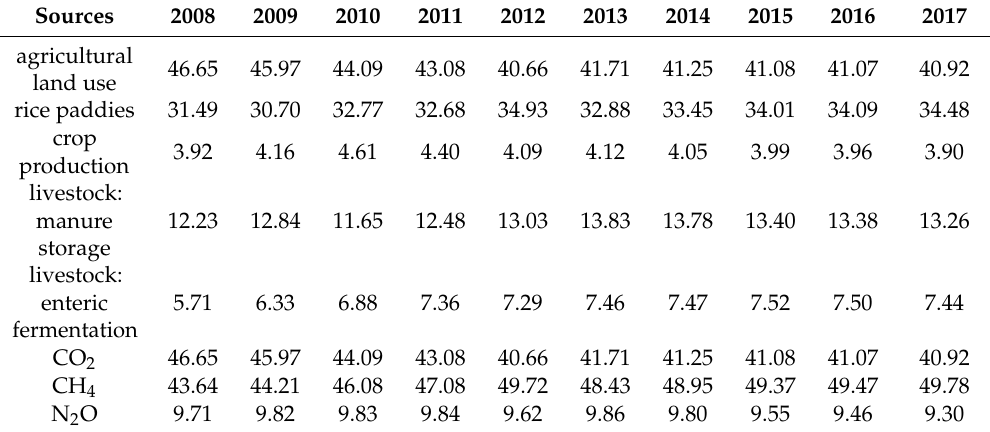
Table 3. The proportion of sources of agricultural carbon emissions in Fujian (units: %).